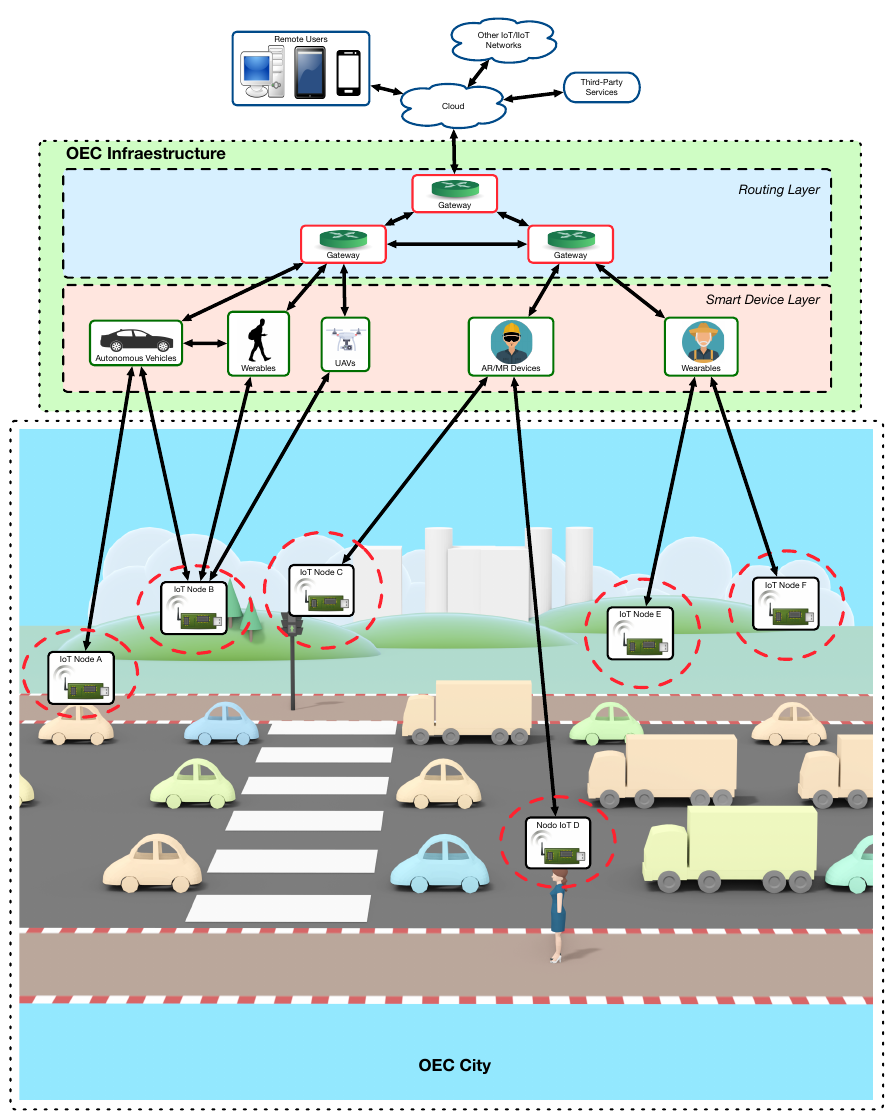
Figure 1. Example of OEC architecture for a smart